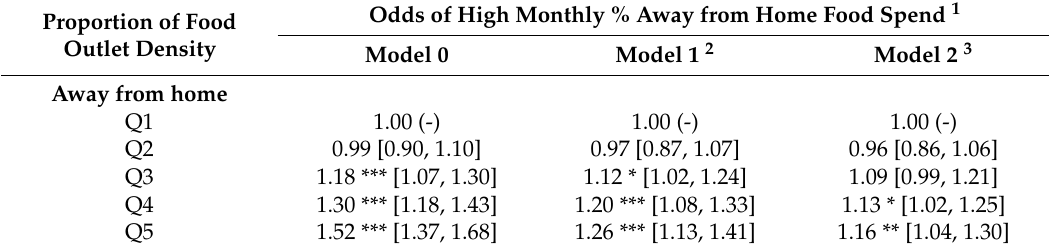
Table 3. Odds ratios and 95% confidence intervals for high % (top tertile) of away from home food spend (N = 24,047) by quintile of proportion of away from home food outlets exposure. Odds of High Monthly % Away from Home Food Spend 1 Proportion of Food Outlet Density Model 0 Model 1 2